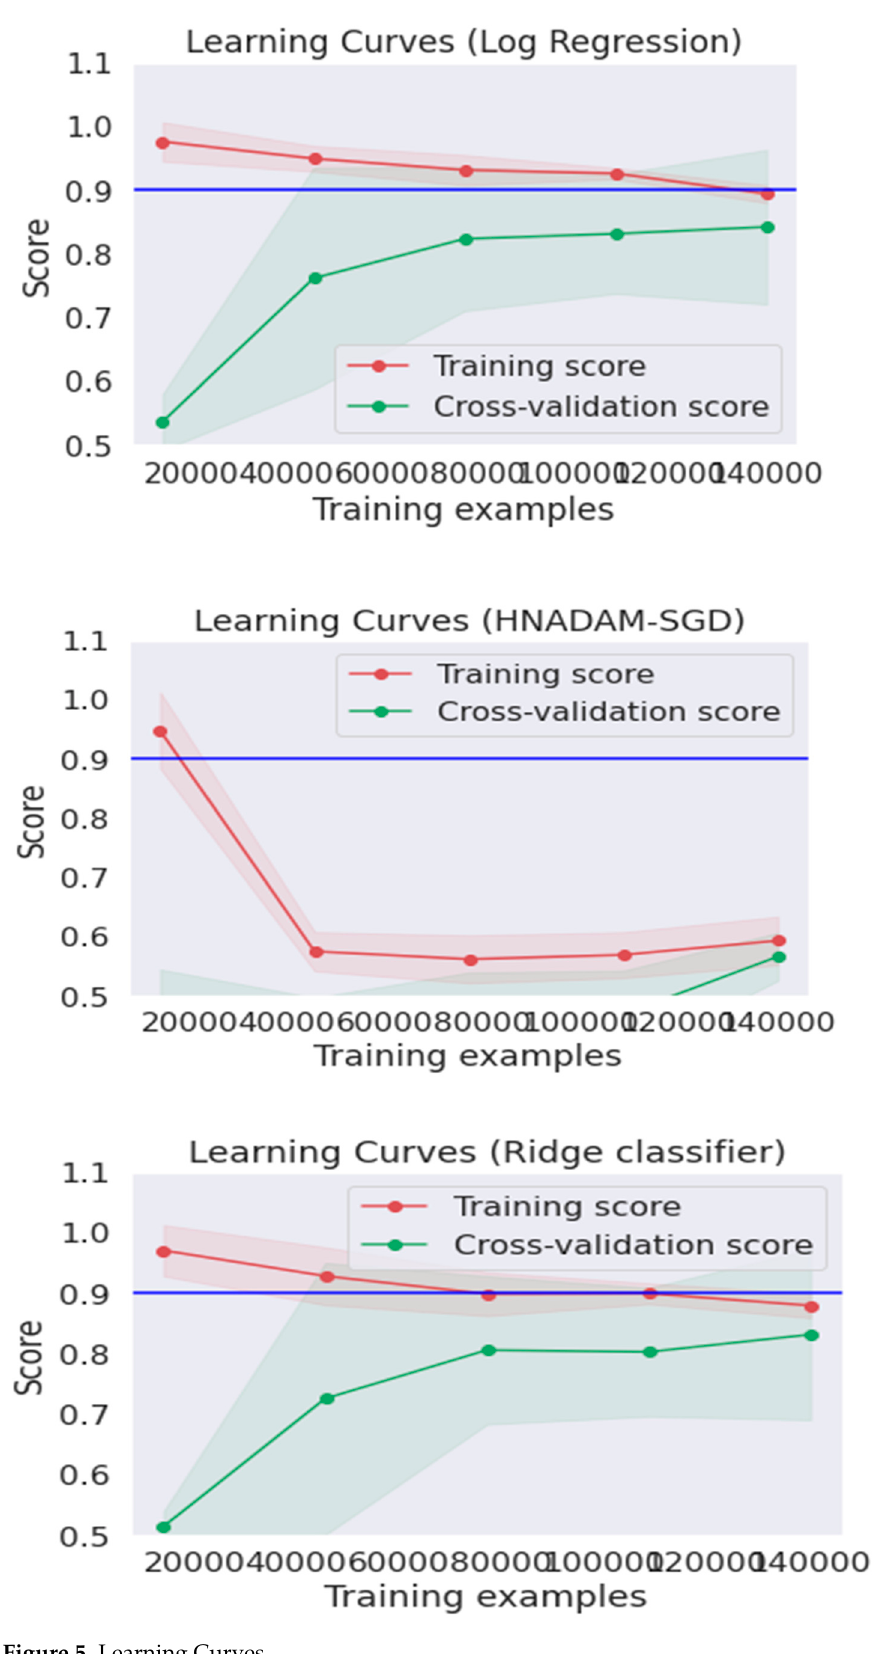
Figure 5. Learning Figure 5. Learning Curves.